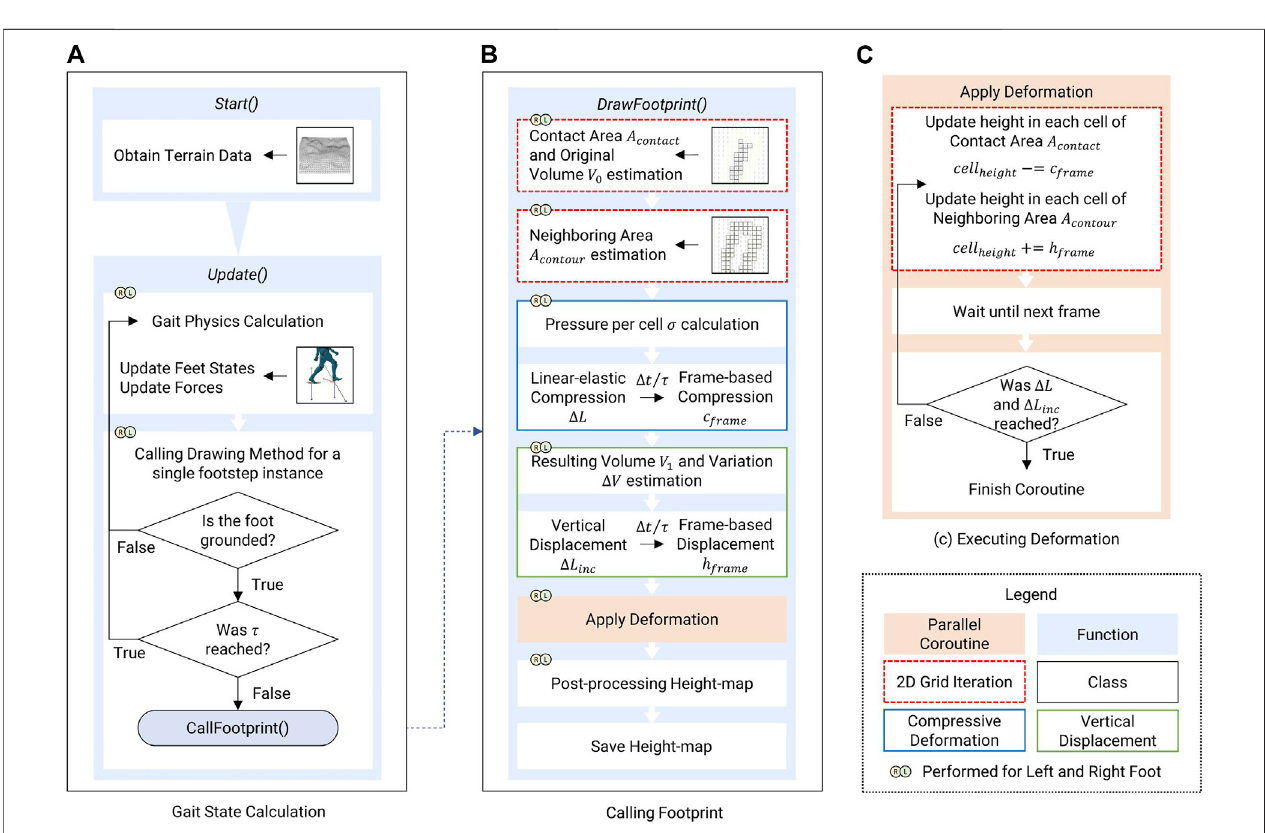
FIGURE 2 | Framework for terrain deformation. Block (A) is in charge of calculating the forces taking place at each frame and then initializes block (B) , where footprints are computed. The coroutine (C) computes the associated deformation and terminates when the terrain displacement is completed.